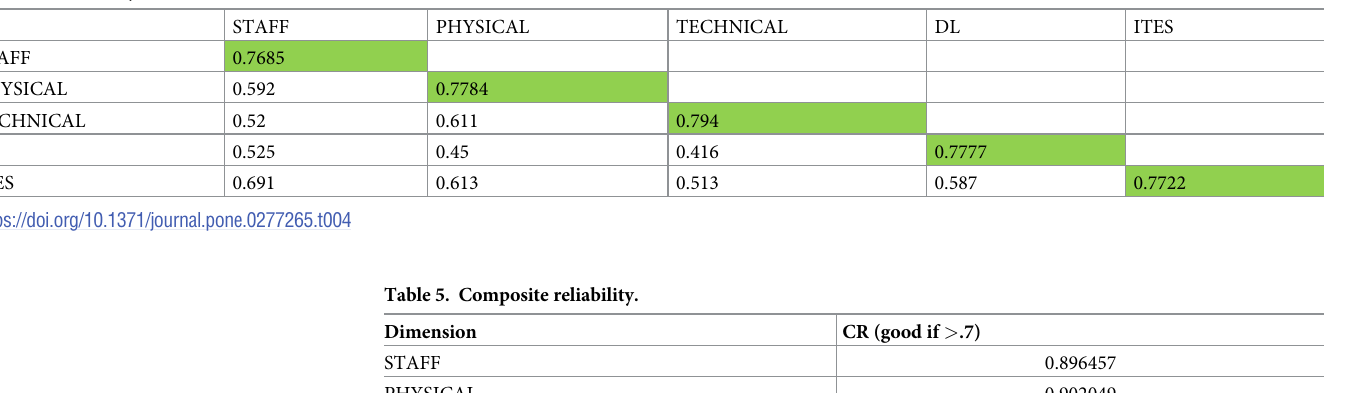
Table 4. AVE analysis.